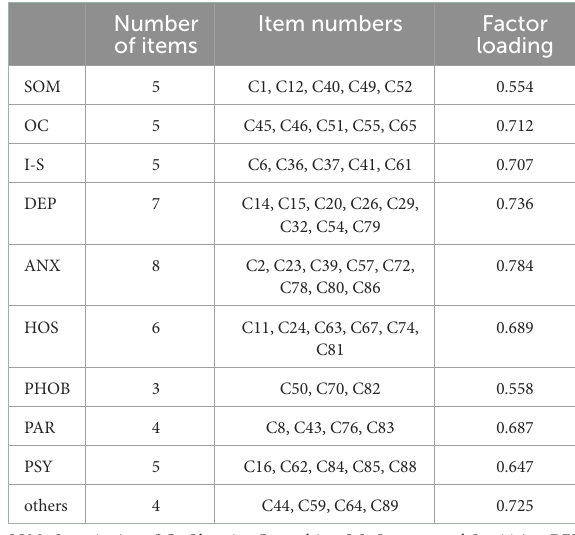
TABLE 2 Number of items and factor loadings included in the IPSI